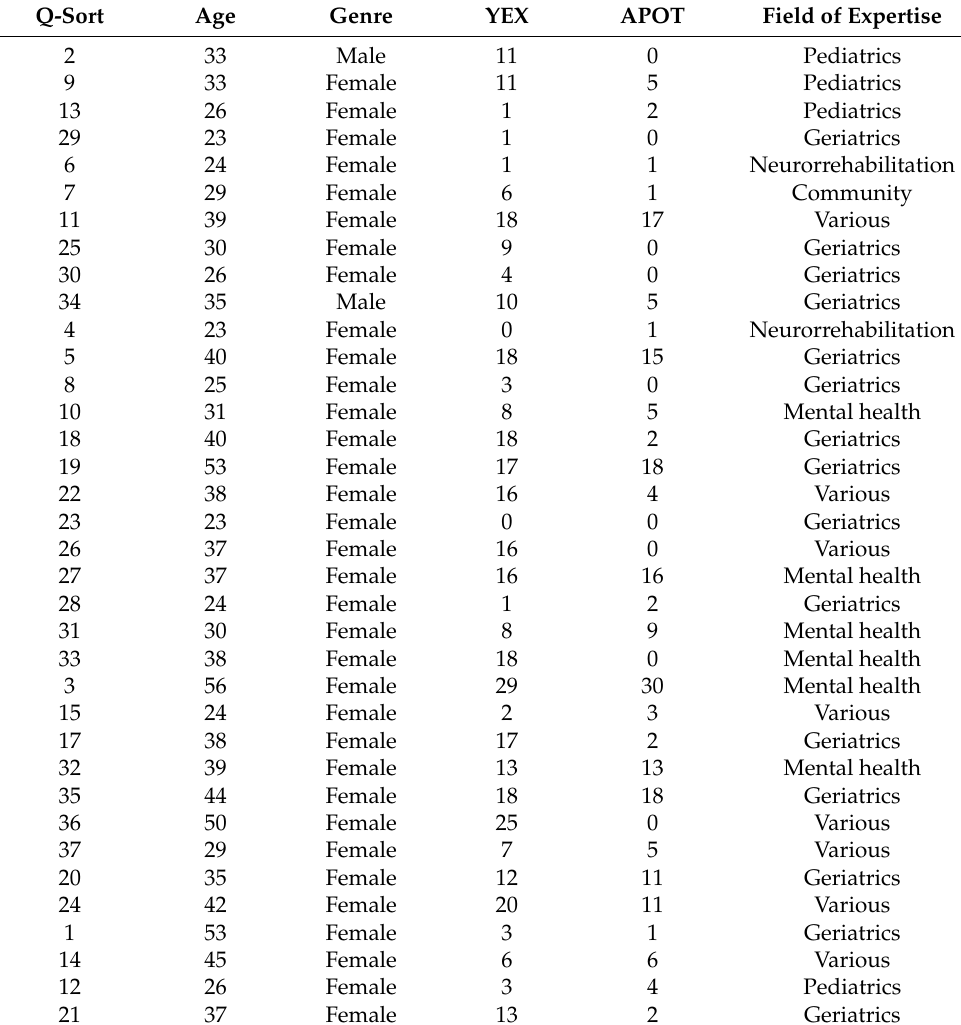
Table 2. Participant variables and